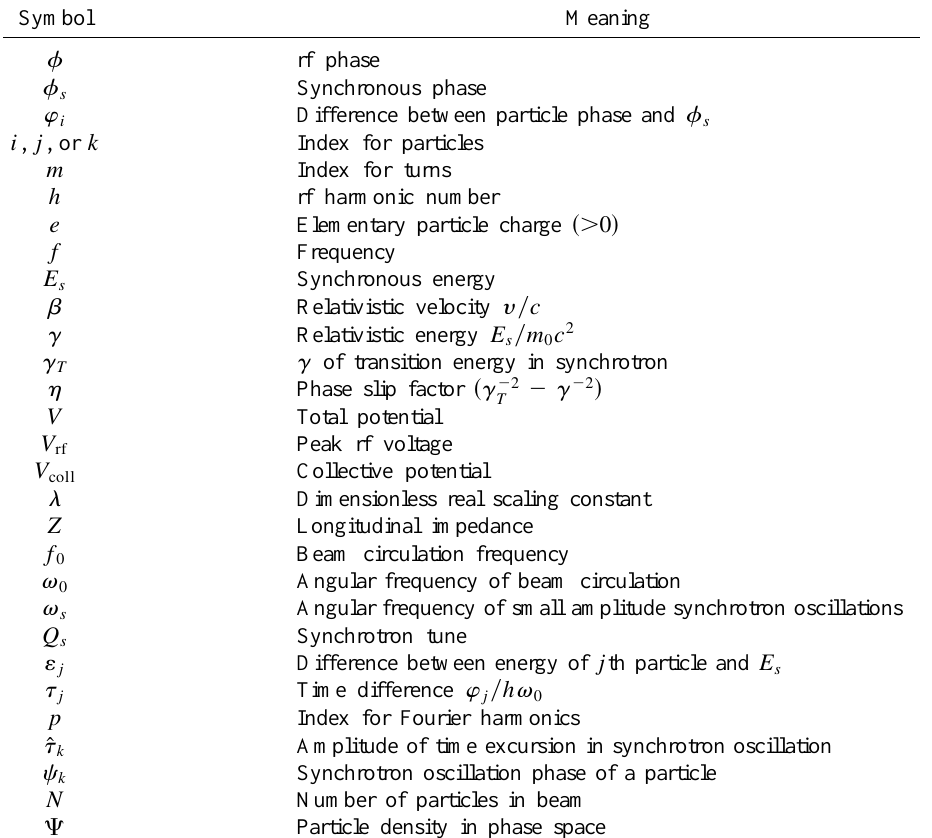
TABLE I. Definition of frequently used